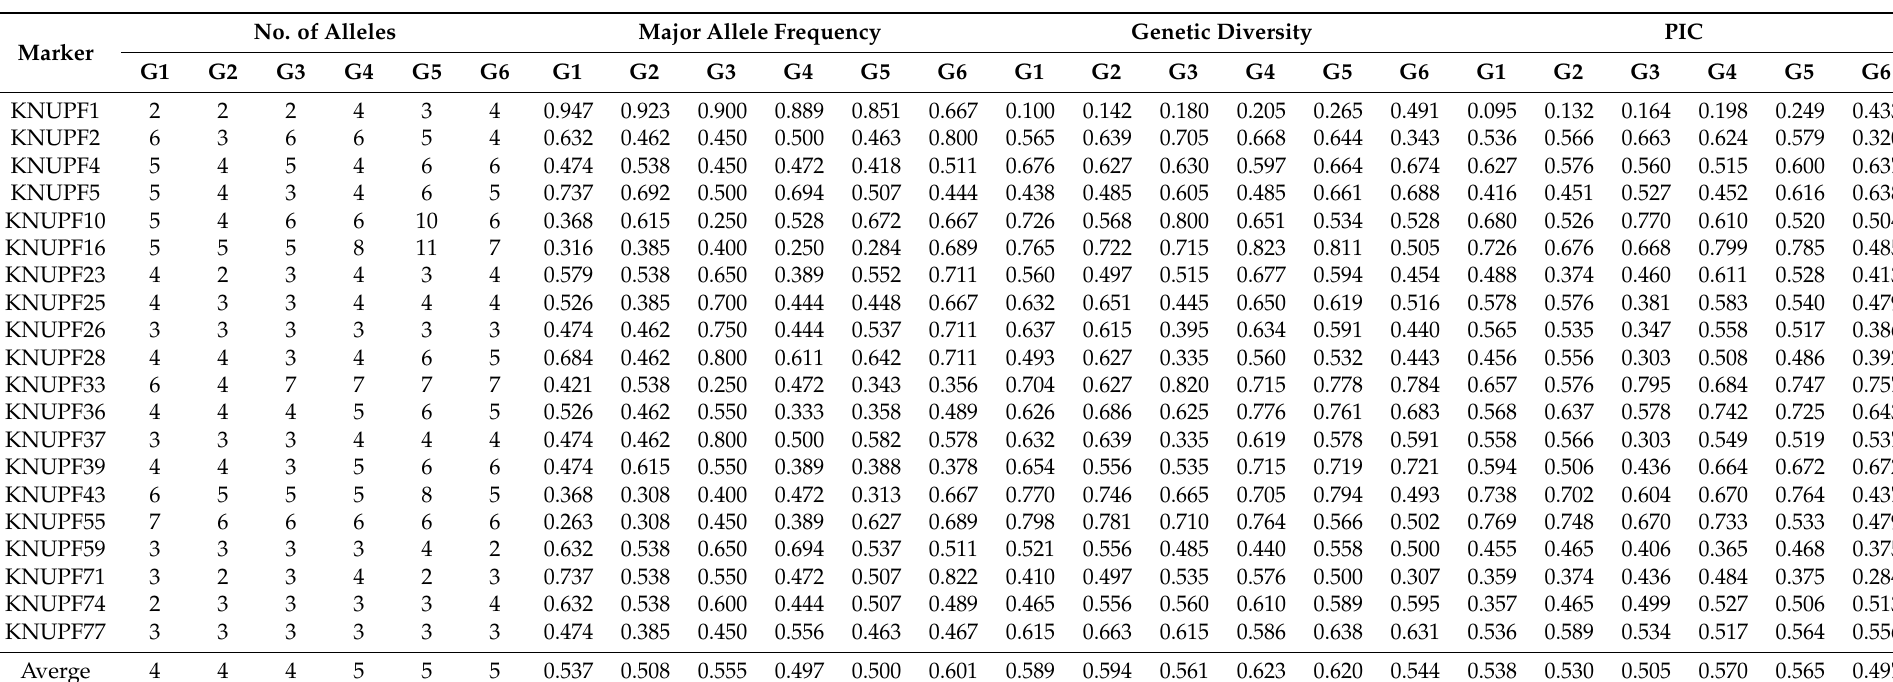
Table 3. Estimates of MAF, allele number, genetic diversity and PIC of 20 Perilla SSR loci collected in five regions from South Korea and other